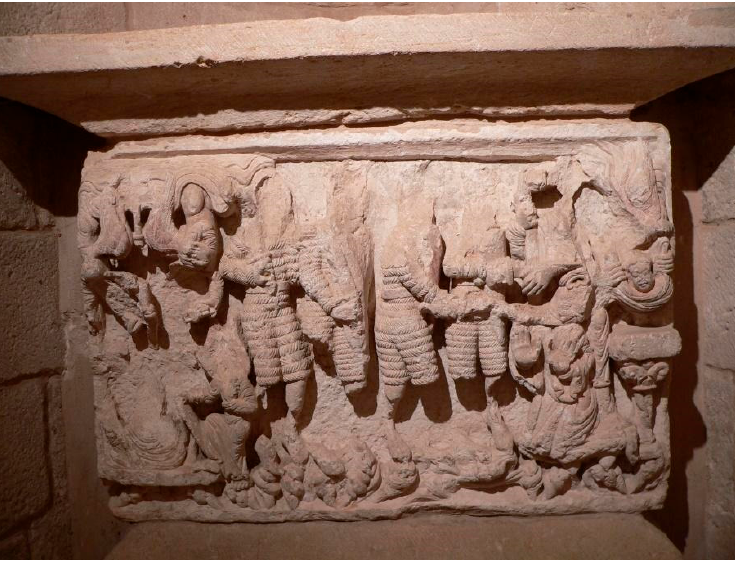
Figure 8. San Miguel de Almazán (Soria): altar frontal (c. 1200). © Photo: Juan Antonio Olañeta.